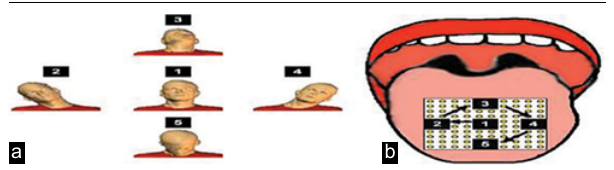
Sensory coding schemes for the tongue display unit (TDU) (b) as a function of the head orientation with respect to gravitational vertical (a). (1) Neutral, (2) right-side-tilted, (3) extended, (4) left-side-tilted and (5) flexed head postures (quoted from Vuillerme and